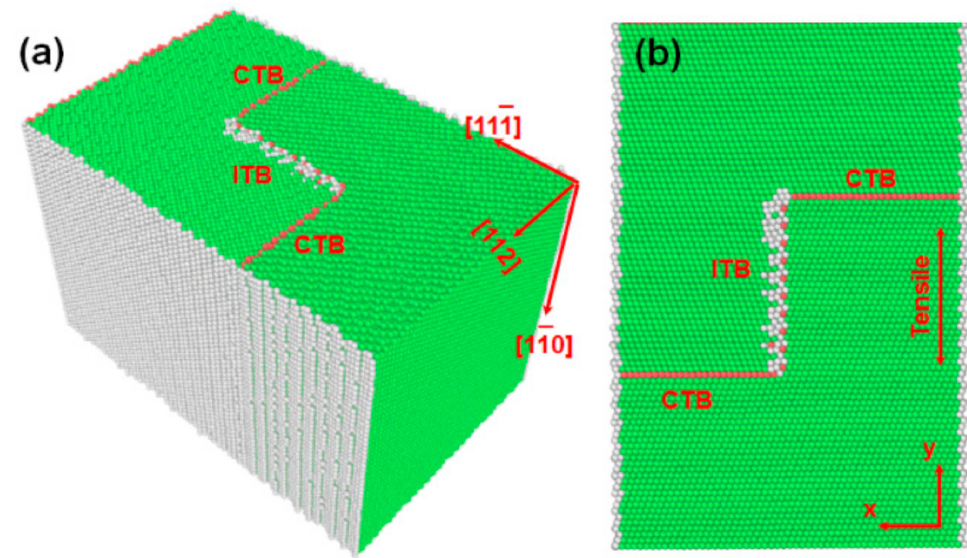
Figure 1. Atomistic model of the twin-structured nanocrystal with ITB. ( a ) Three-dimensional structure of the twinned nanocrystals, with the tensile direction along [111]; ( b ) a typical image of the twin-structured nanocrystal viewed along [110]. Atom colors correspond to the crystal structure according to common neighbor analysis. The red atoms are CTBs, the green atoms are FCC, and the other atoms are